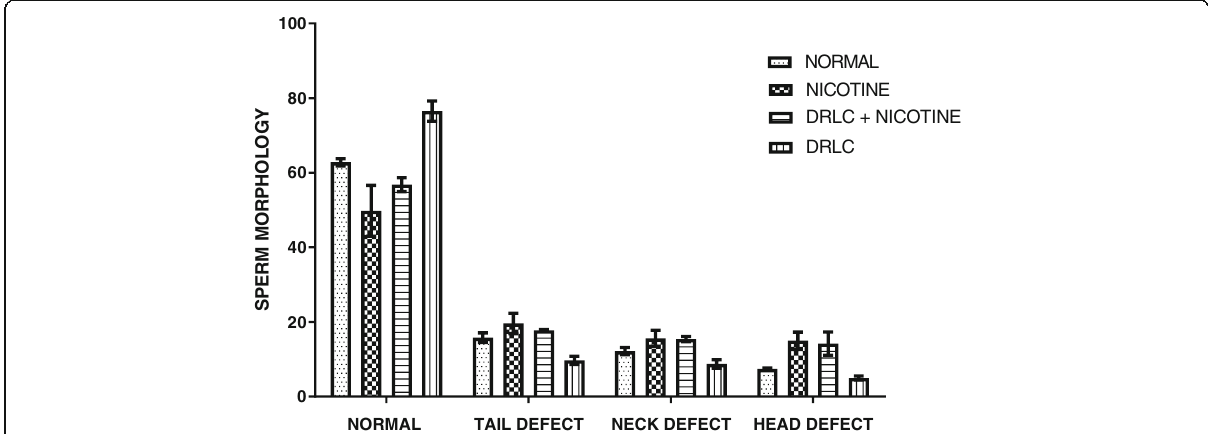
Fig. 11 Chart showing the sperm morphology of the experimental animals. Values are mean ± SEM. N = 5